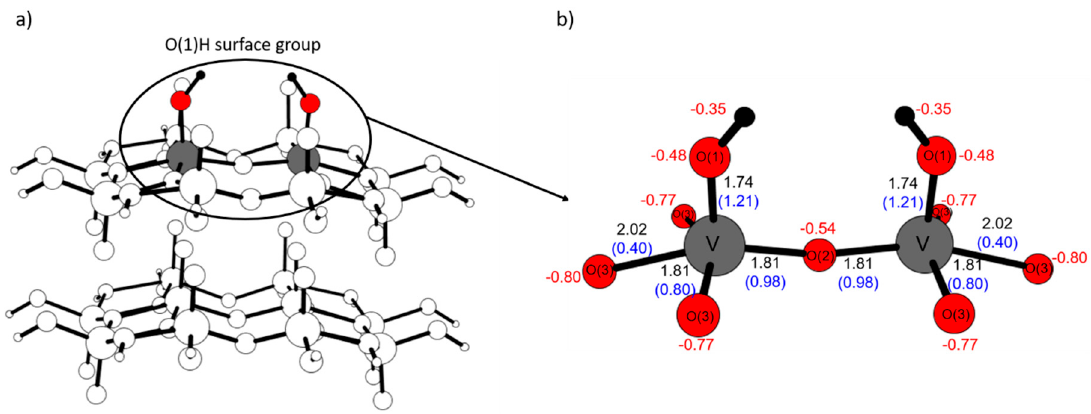
Figure 11. ( a ) V 20 O 62 H 22 (2H + ) cluster representing the results of 2H + adsorption at O(1)O(1) on the (010) V 2 O 5 surface—side view; ( b ) parameters characterizing V–OH surface group and their neighbors (black—bond lengths in Å; blue, in parentheses—bond order indices; red—Mulliken charges).